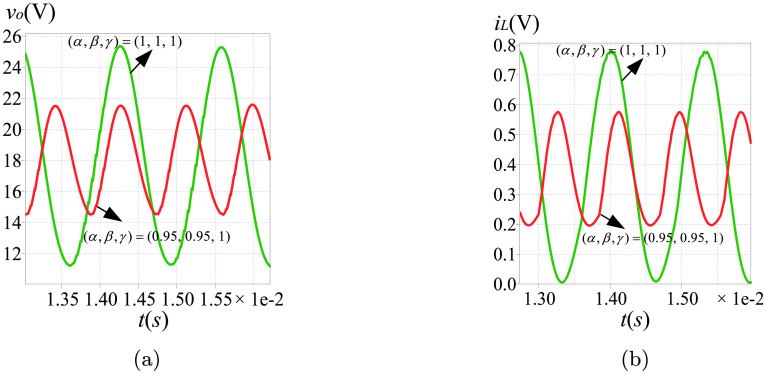
Circuit simulation results of (a) vo; (b) iL.